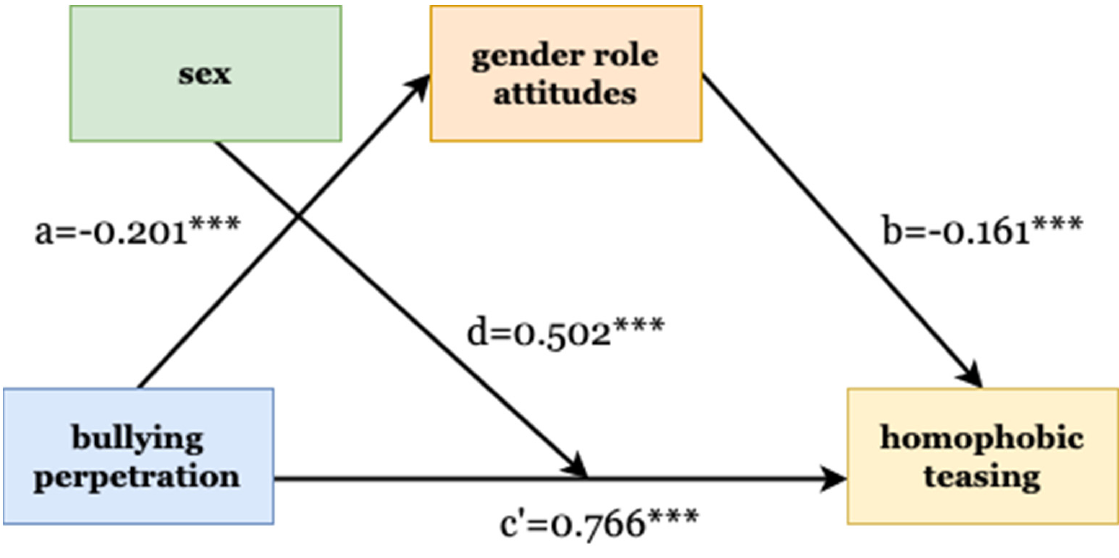
Figure 1. Structural model of relations between variables . *** = p < 0.01 .